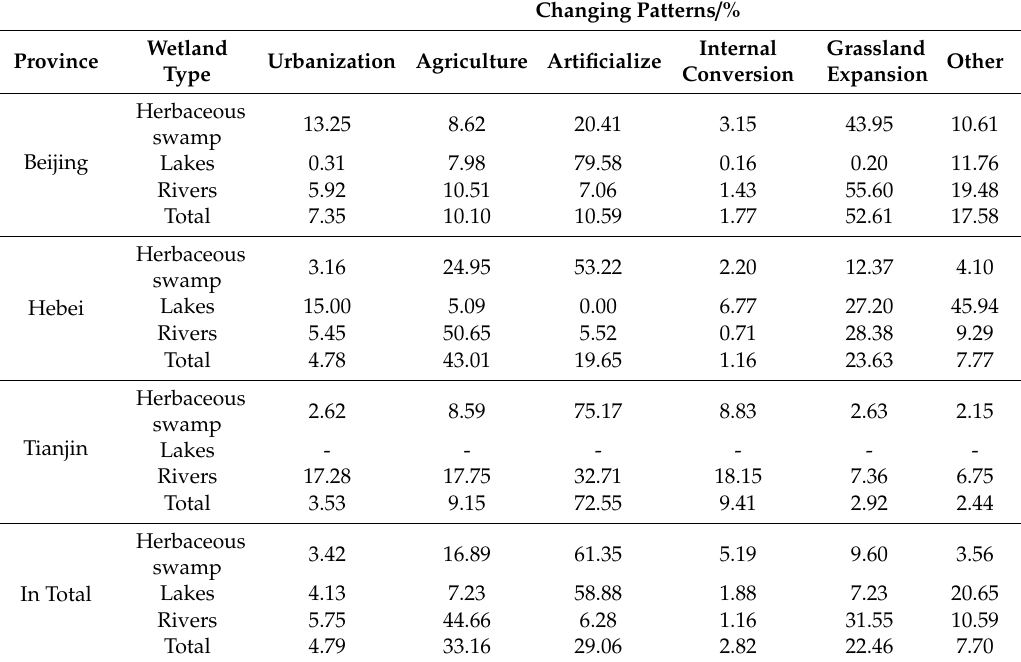
Table 3. Contribution of di ff erent driving forces calculated as the percentage change between 2000 and 2015 in di ff erent provinces in Beijing-Tianjin-Hebei region